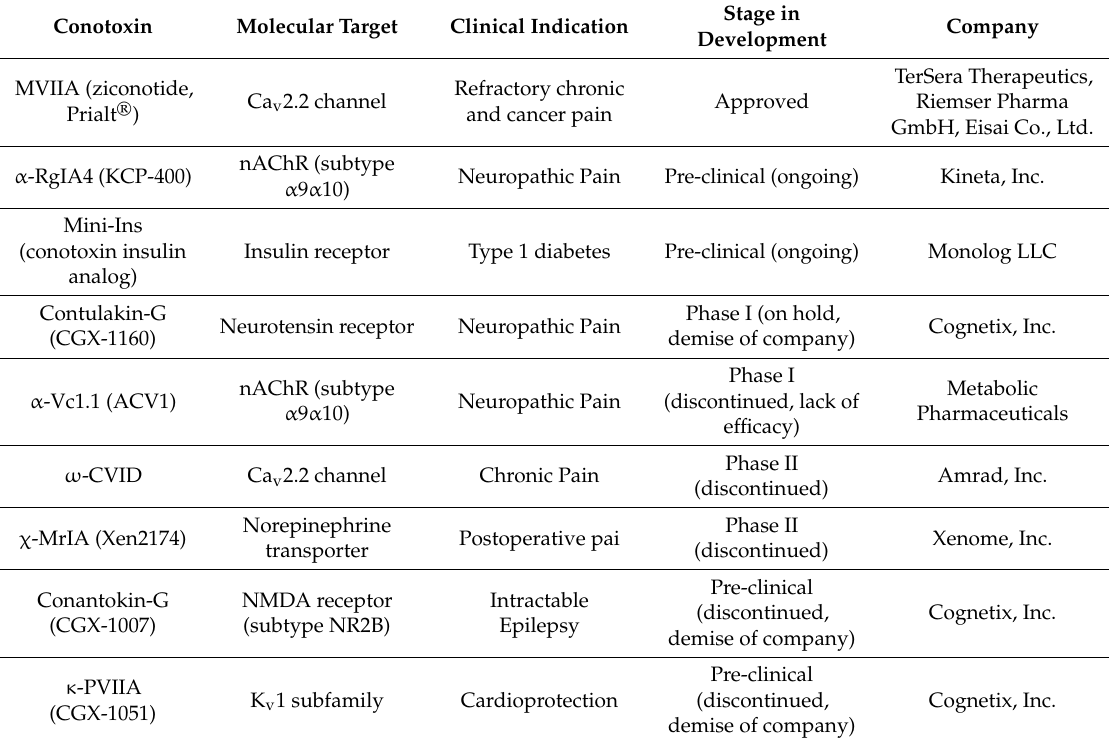
Table 2. Overview of conotoxin drug